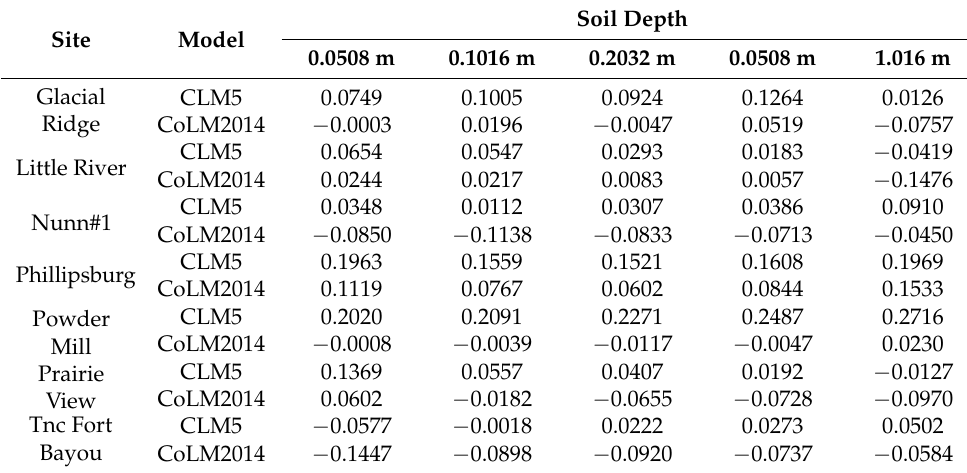
Table 3. Bias of simulated soil moisture at the selected SCAN sites.